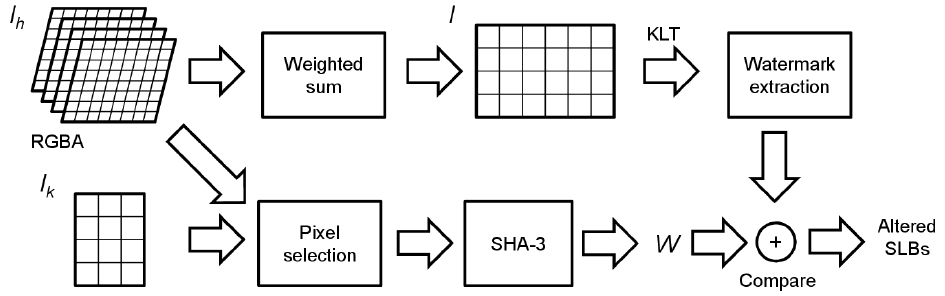
Figure 6. Diagram showing the main elements involved in watermark verification.